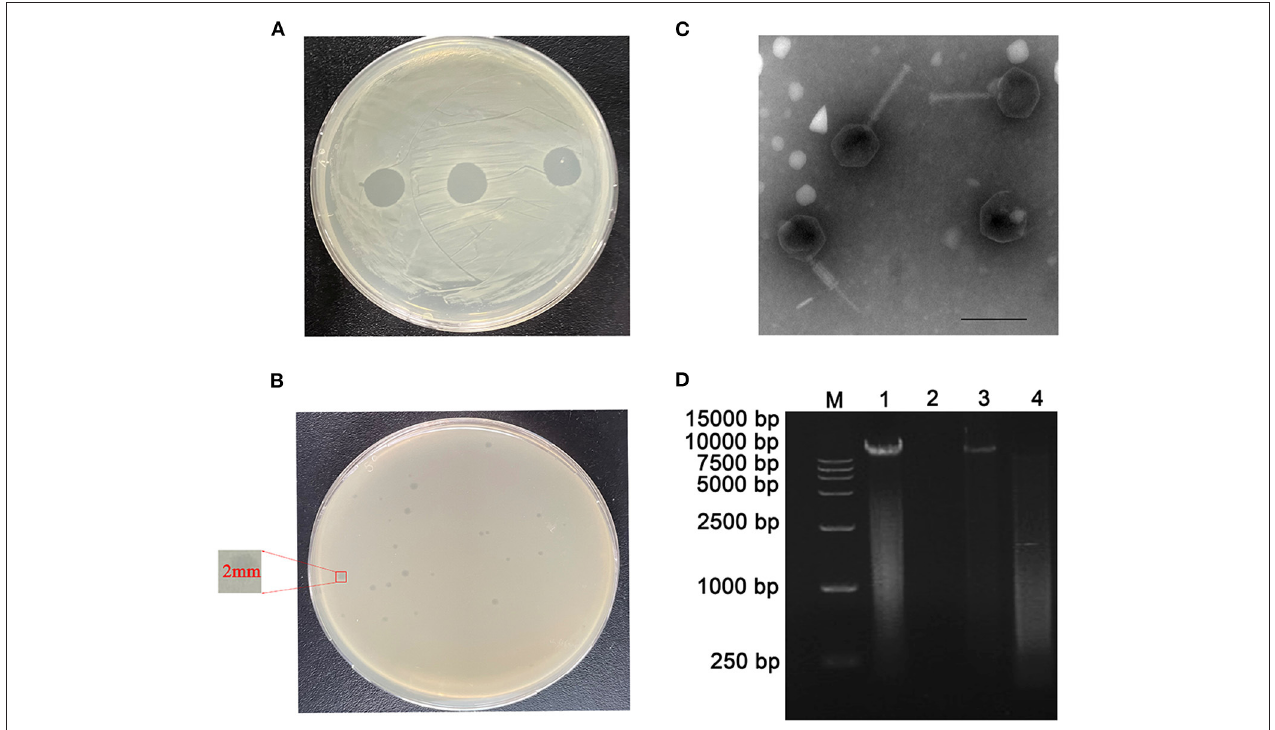
FIGURE 1 | Characteristics of phage vB_CbrM_HP1. (A) Spot tests of phage vB_CbrM_HP1. (B) Plaque observation of phage vB_CbrM_HP1. Each single plaque was ≈ 2mm in diameter. (C) Transmission electron microscopy (TEM) of phage vB_CbrM_HP1 at an accelerating voltage of 80 kV. Phage vB_CbrM_HP1 negatively stained with 2% phosphotungstic acid (PTA), and the scale bars represent 100nm. (D) Nucleic acid type identification of phage vB_CbrM_HP1. M: 15,000 bp Marker; 1: nucleic acid of phage; 2: DNase I (10.0 U/ µ g); 3: RNase A (10.0 U/ µ g); 4: mung bean nuclease (20.0 U/ µ